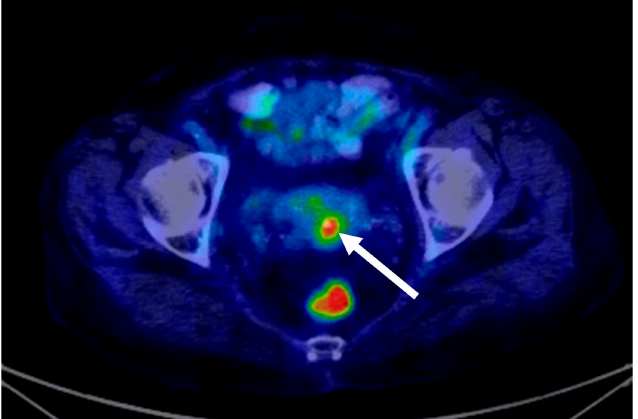
Figure 2. Residual lymphomatous cervical tumour post-chemotherapy, six rounds: PET-CT (Positron Emission Tomography—Computed Tomography) scan.